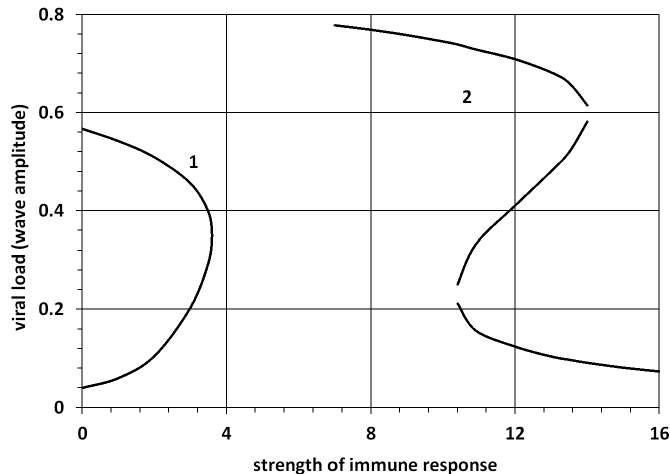
Figure 7. Dependence of the viral load (wave amplitude) on the strength of immune response ( a 1 ) for the 1D problem. The wave amplitude is found as a solution of the equation F λ ( v ) = 0. The values of parameters: D x = D y = 0.005, b = 1, k = 1, f ( v ) = ( a 1 v + a 2 ) e − a 3 v , Curve 1: a 2 = 0.7, a 3 = 6, λ = 0.41 ( y 0 = 0.1). Curve 2: a 2 = 0, a 3 = 6, λ = 0.17 ( y 0 =